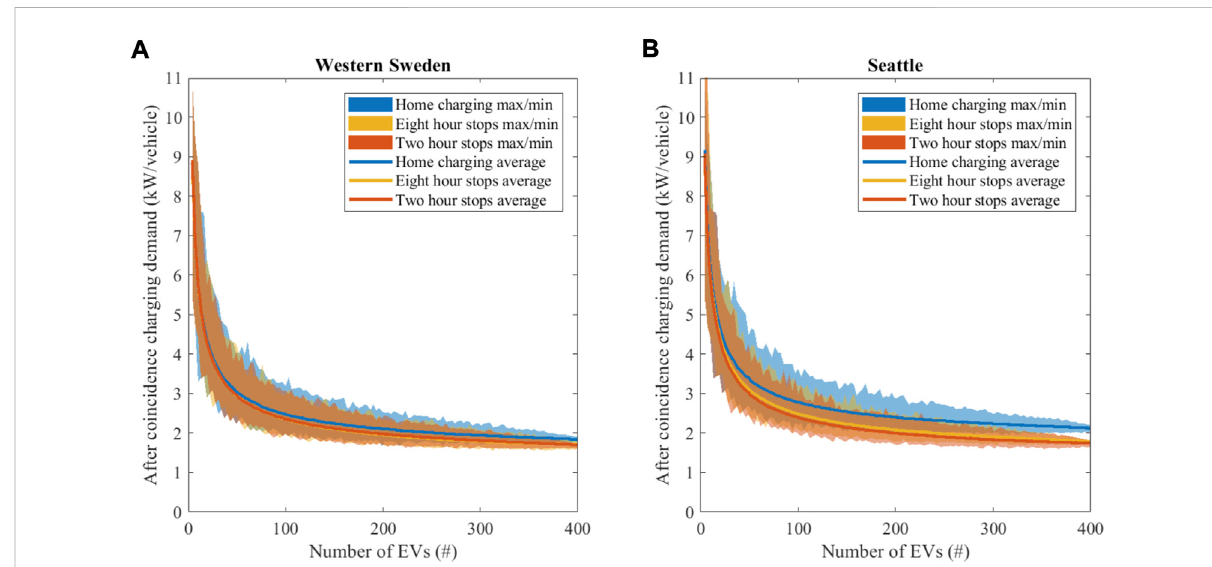
FIGURE 2 After-coincidence charging power demand for the highest hour of the year and as an average for all combinationof vehiclesfor three different charginglocations,(blue)chargingathomelocation,(yellow),chargingwhenthecarisparkedforatleast8 hinarowand(red)chargingwhenthecar is parked for at least 2 h in a row. The nominal charging power is 11 kW and the electricity demand per km is assumed to be 0.2 kWh/km. Data for Western Sweden in (A) and Seattle (B) . Shaded areas show variation (max and min) from the randomized combinations.